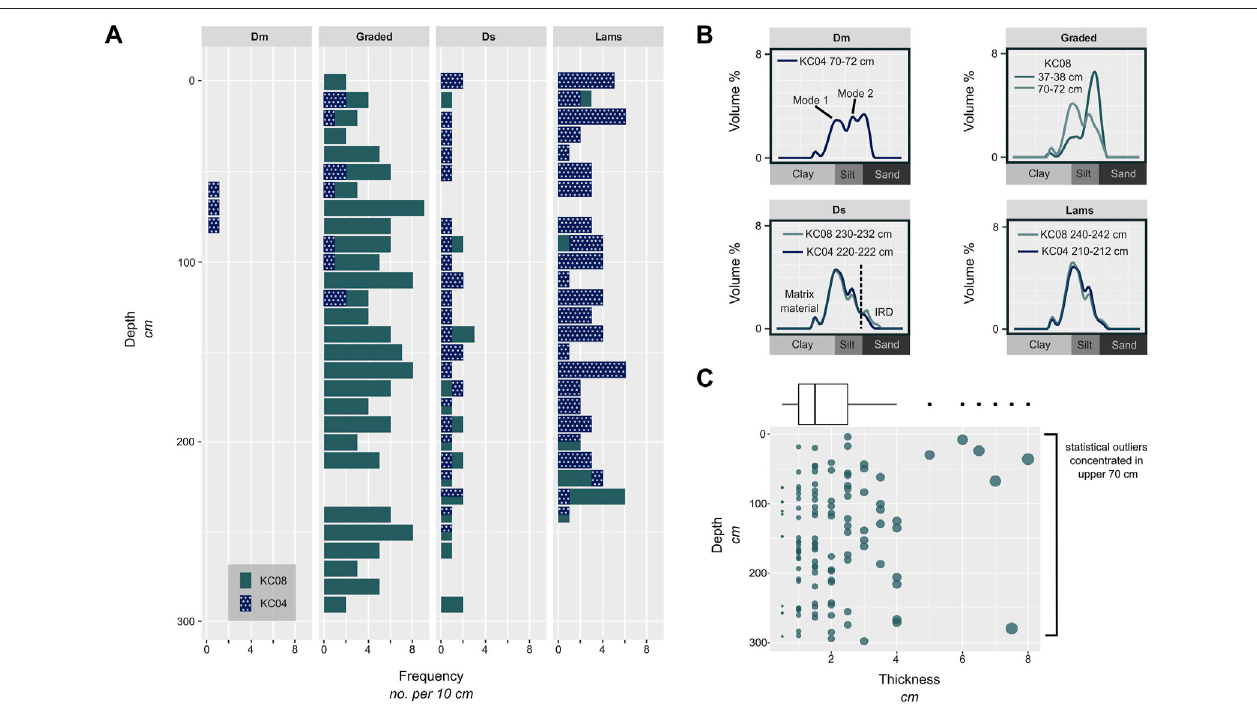
FIGURE 8 | Frequency analysis of sediment layers observed in cores offshore the TGT. (A) Downcore frequency of sediment facies categorized as massive diamicton (Dm), graded silt layers and strati fi ed diamicton (Ds), in addition to laminations and beds within facies Ds (lams). (B) Representative grain-size distributions for each sediment facies. Note that ice-rafted debris in Ds includes only the sand fraction and not coarser clasts. (C) Thickness of graded layers throughout core KC08. Boxplotdenotes75%ofallgradedlayersare ≥ 2.5 cm.Whilethick(i.e., ≥ 5 cm)gradedlayersareconcentratedintheupper70 cmofthecore,acomparablelayeris observed at ~280 cm